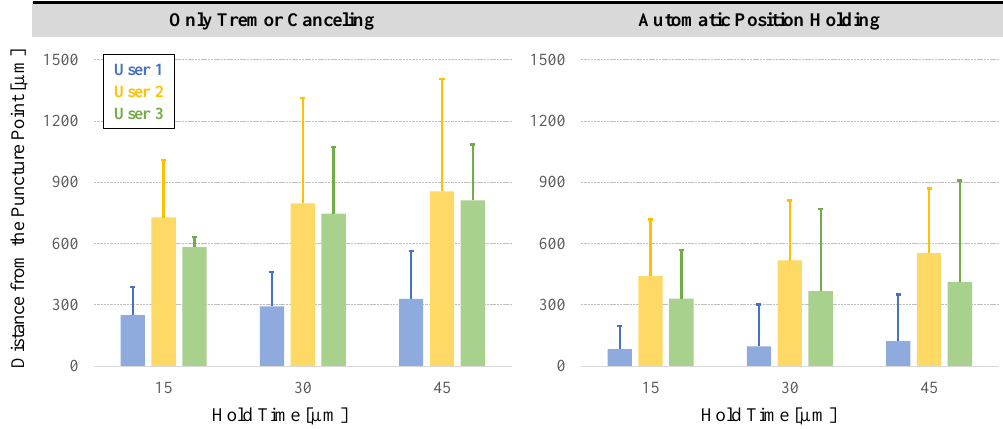
Figure 14. Deviation from the puncture point vs. the hold time for each user. The solid bars show the mean distance from the puncture point, and the error bars represent the maximum values. A longer hold time causes the needle to move away from the puncture point more. The automatic position holding mode significantly helps in keeping the needle tip proximal to the puncture point.